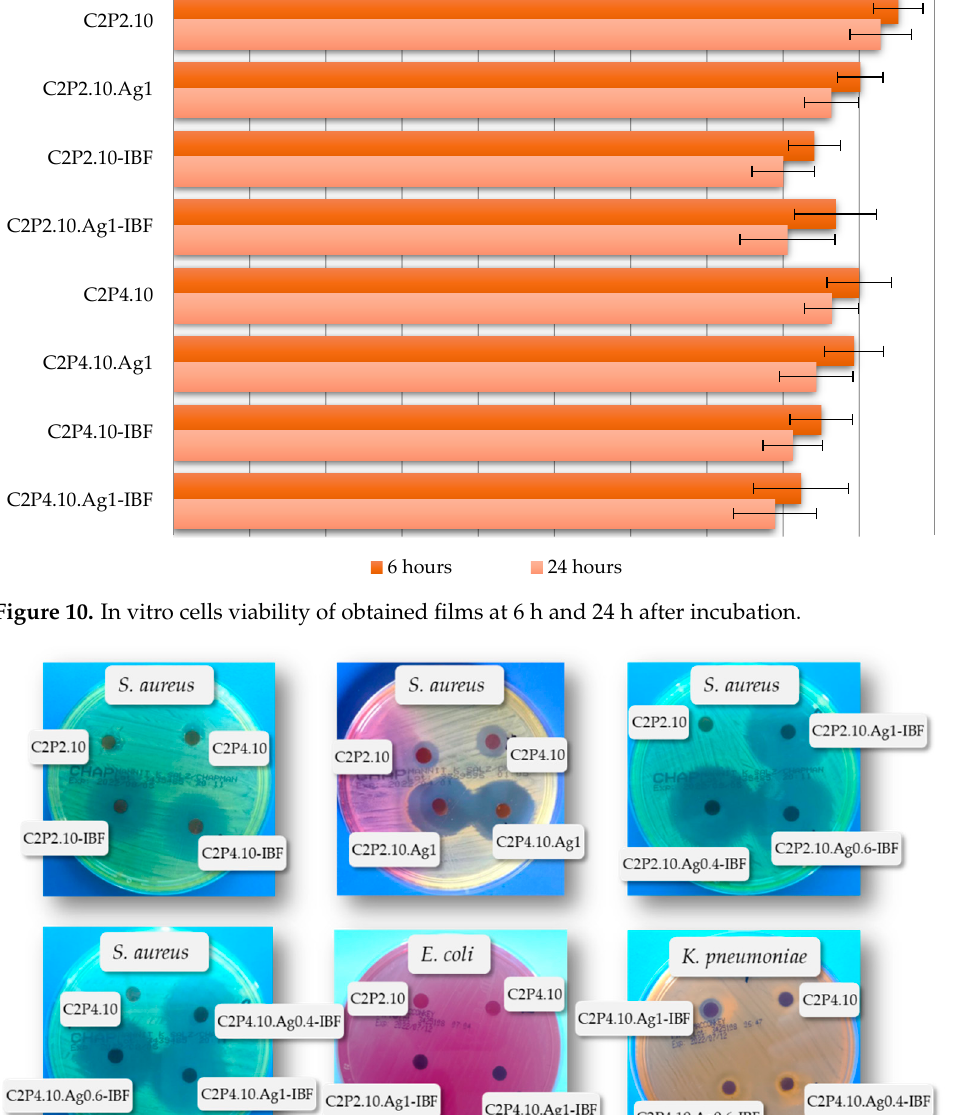
Figure 12. Diameter of inhibition zone of bacteria against S. aureus (green bars), E. coli (red bars) and K. pneumonia (orange bars) obtained after 24 h of incubation at 37 °C in the presence of film samples with and without the drug and with different percentages of AgNPs in the composition . In the case of gram-negative bacteria, no antimicrobial activity was demonstrated. Both CS and AgNPs have antimicrobial activity against S. aureus proven by studies in the literature [39,23]. Consequently, the film samples containing AgNPs show significant antibacterial properties against S. aureus , while the samples without AgNPs have no de- -